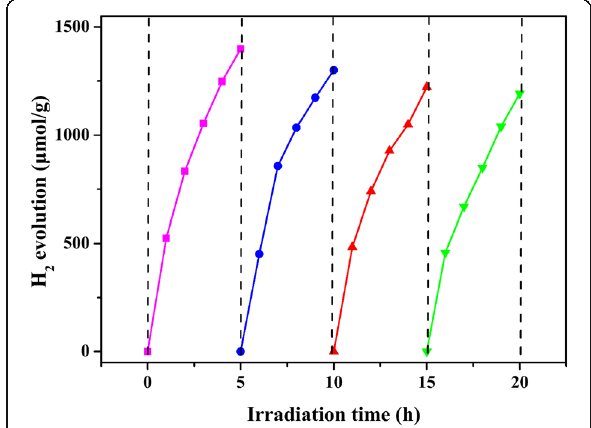
Fig. 6 Cyclic H 2 production for the g-C 3 N 4 /PtNi/GO-0.5% sample. Light source: 300 W Xenon lamp ( λ > 420 nm), Reaction